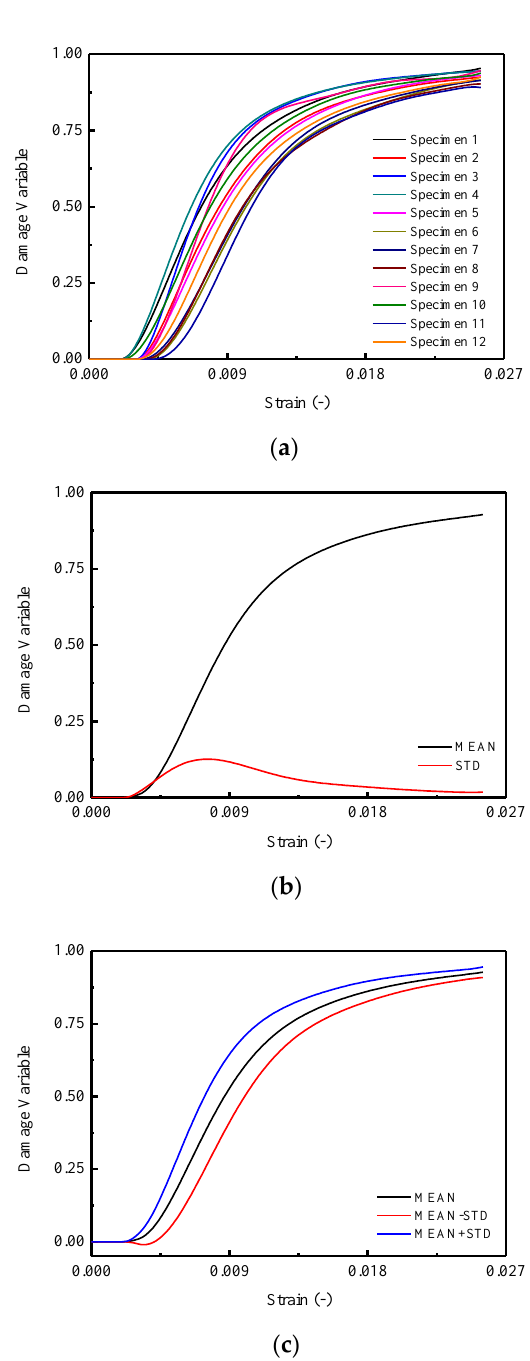
Figure 10. The damage variable d of CA mortar specimens: ( a ) Damage variable d of specimens; ( b ) Mean and STD. of damage variable d ; ( c ) Mean ± STD. of damage variable d .